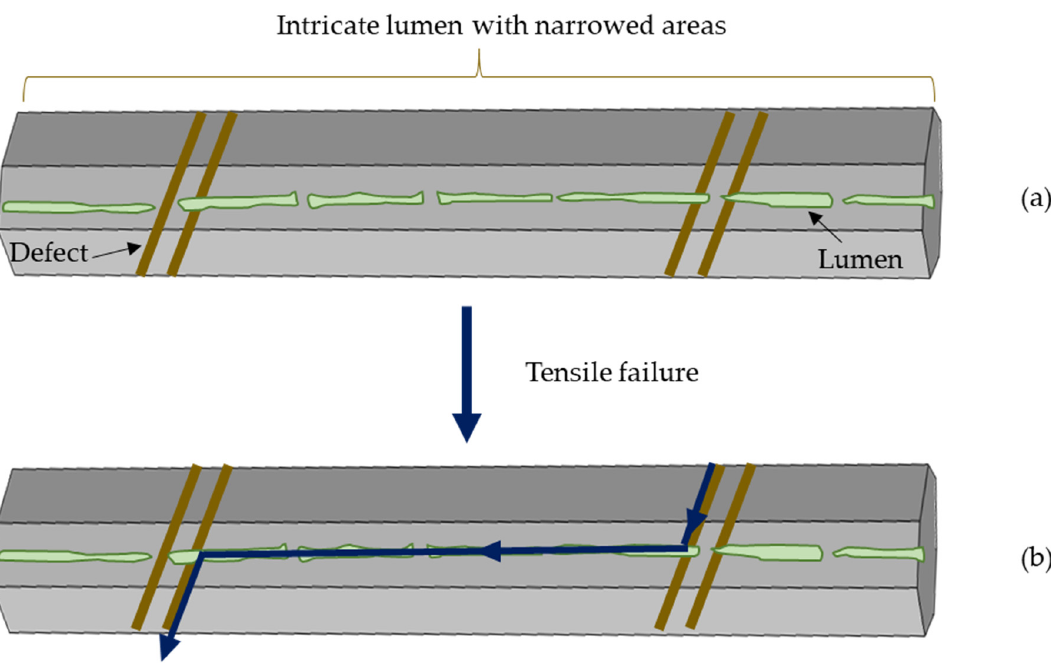
Figure 13. ( a ) Schematic representation of the intricate shape of flax fibre lumen and ( b ) proposed scenario for fibre tensile failure.